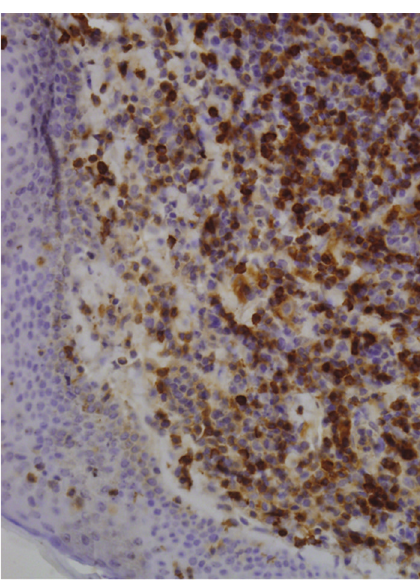
Figure 4: Positive CD5 immunoreactivity in cytoplasm of lym- phoma cells (40x).